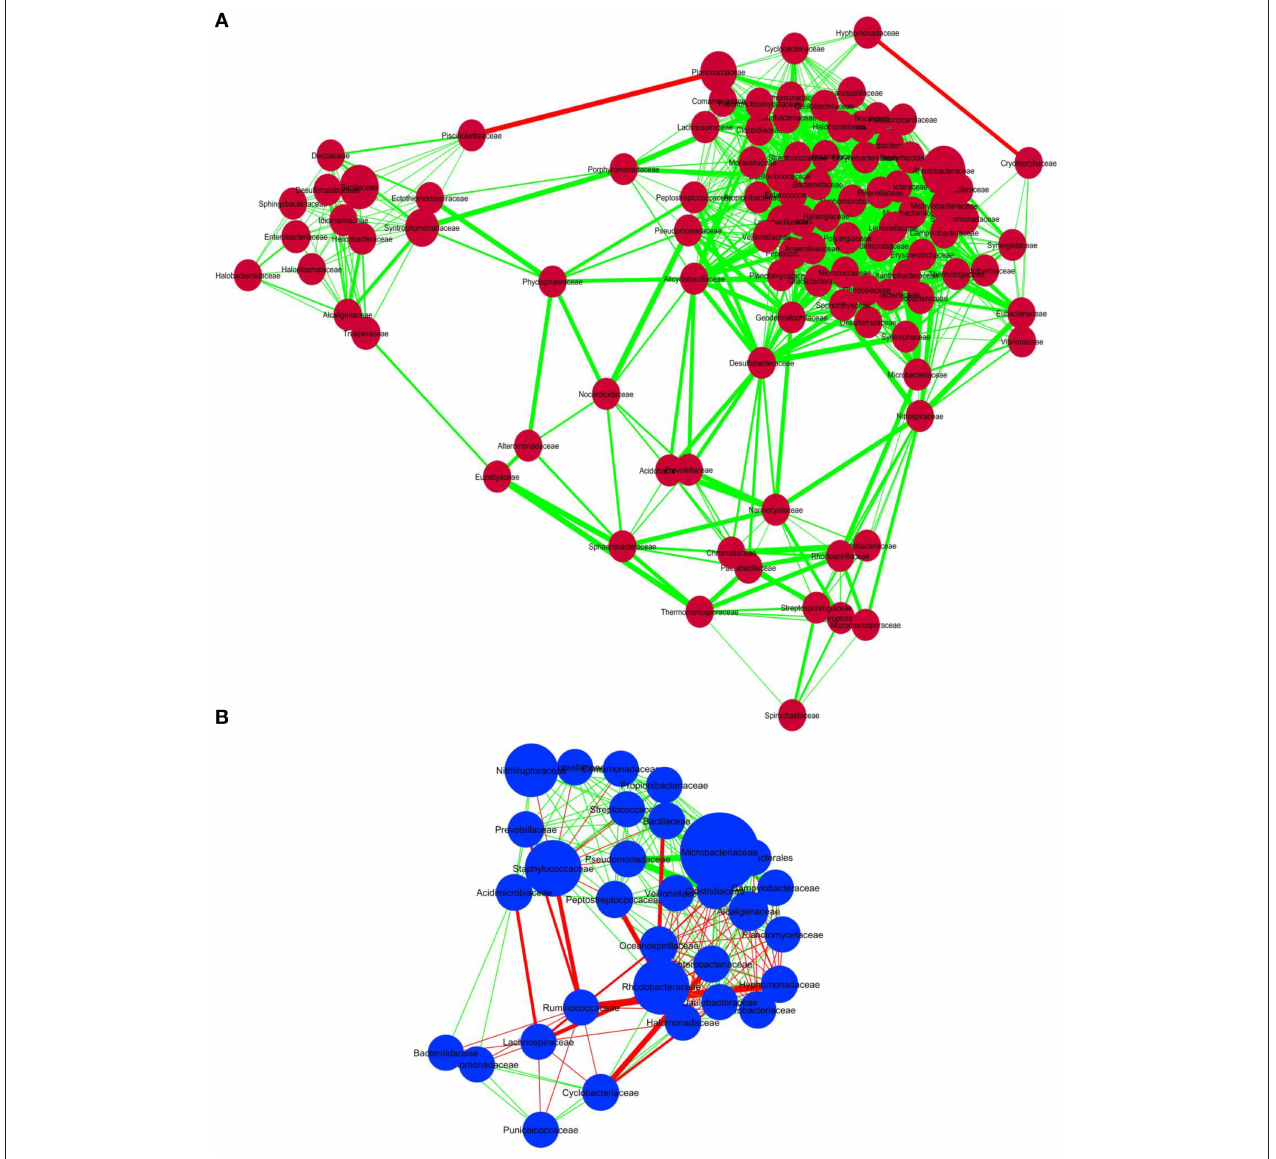
FIGURE 4 | Co-occurrence analysis of the bacteria members (A) sediment samples and (B) water samples of Lonar Lake at family level. Diagram shows the interactions among different bacteria. Red line indicates negative association and green line indicates positive association. The thickness of the line indicates strength of interaction and the size of the bubble indicates the relative abundance of bacterial